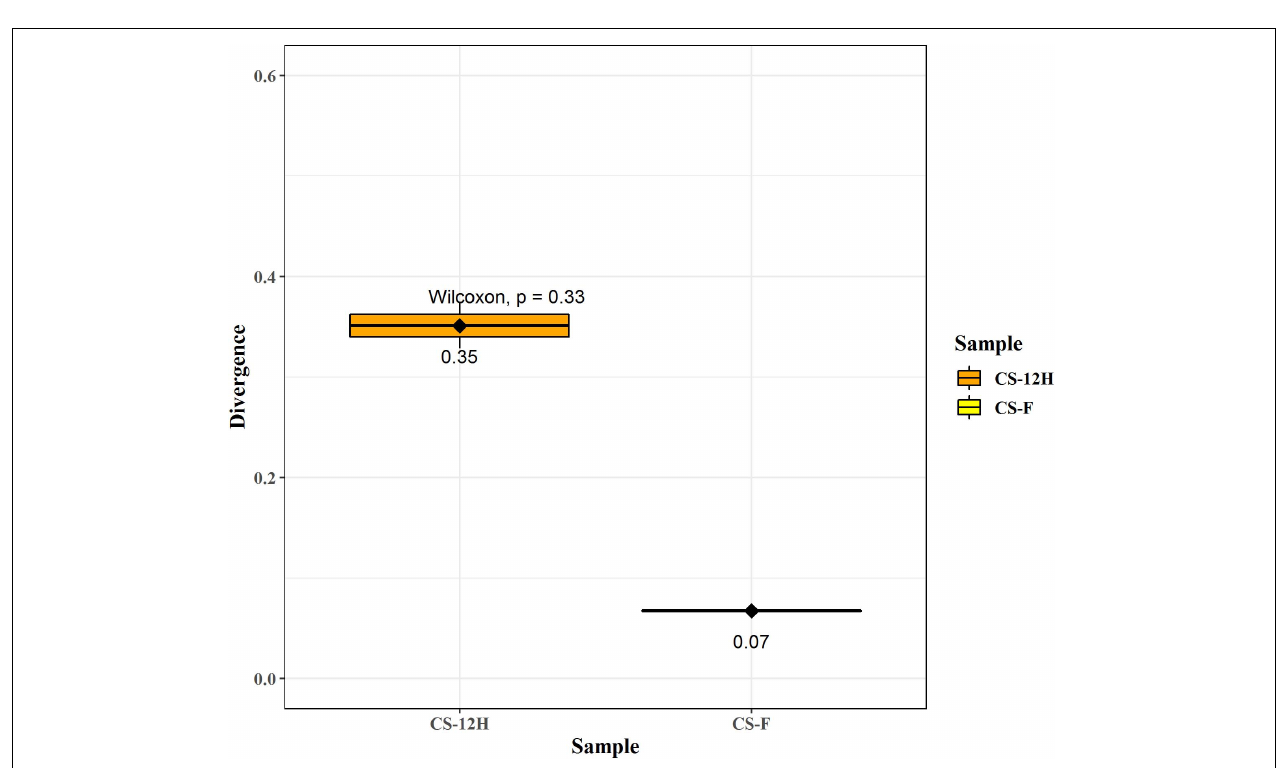
FIGURE 6 | Alpha diversity indices (for observed, Chao1, ACE, and Fisher measures) for fungal reads in fresh (CS-F) and 12-h fermented (CS-12H) Kalparasa .